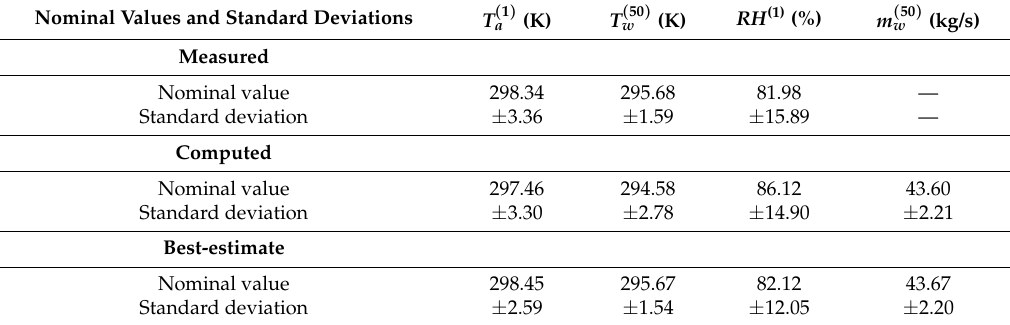
Table 6. Computed, measured, and optimal best-estimate nominal values and standard deviations for the outlet air temperature, outlet water temperature, outlet air relative humidity, and outlet water flow rate